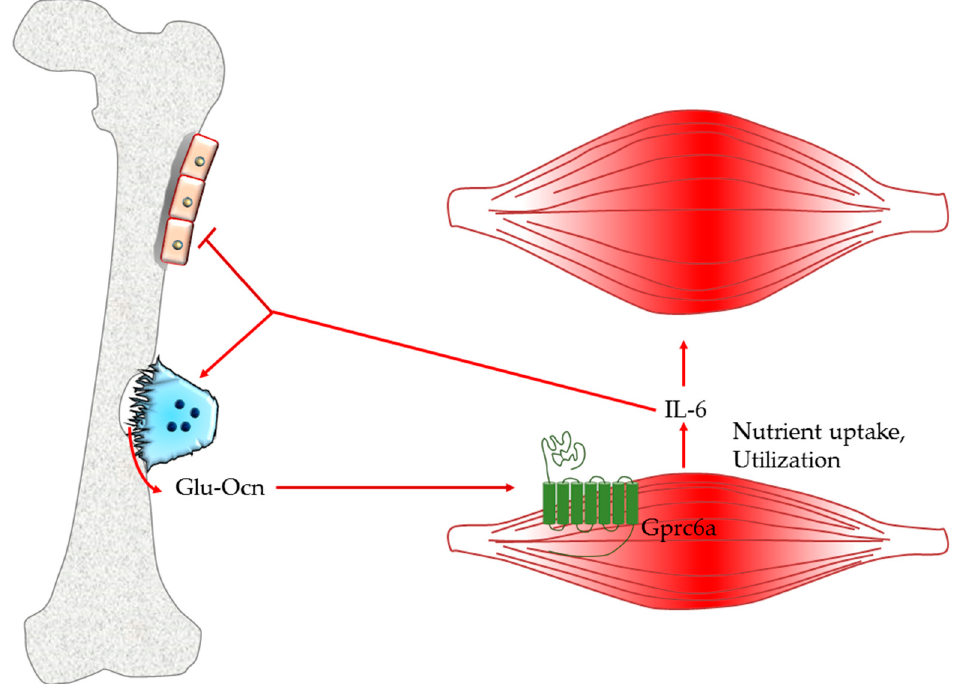
Figure 2. Osteocalcin. The undercarboxylated form of osteocalcin is released during bone resorption. The hormone binds its receptor, gprc6a, expressed on muscle cells stimulating nutrient uptake and the secretion of interleukin 6. In turn, IL-6 reduces osteoblast activity, stimulates bone resorption and induces increase of muscle mass in response to exercise.